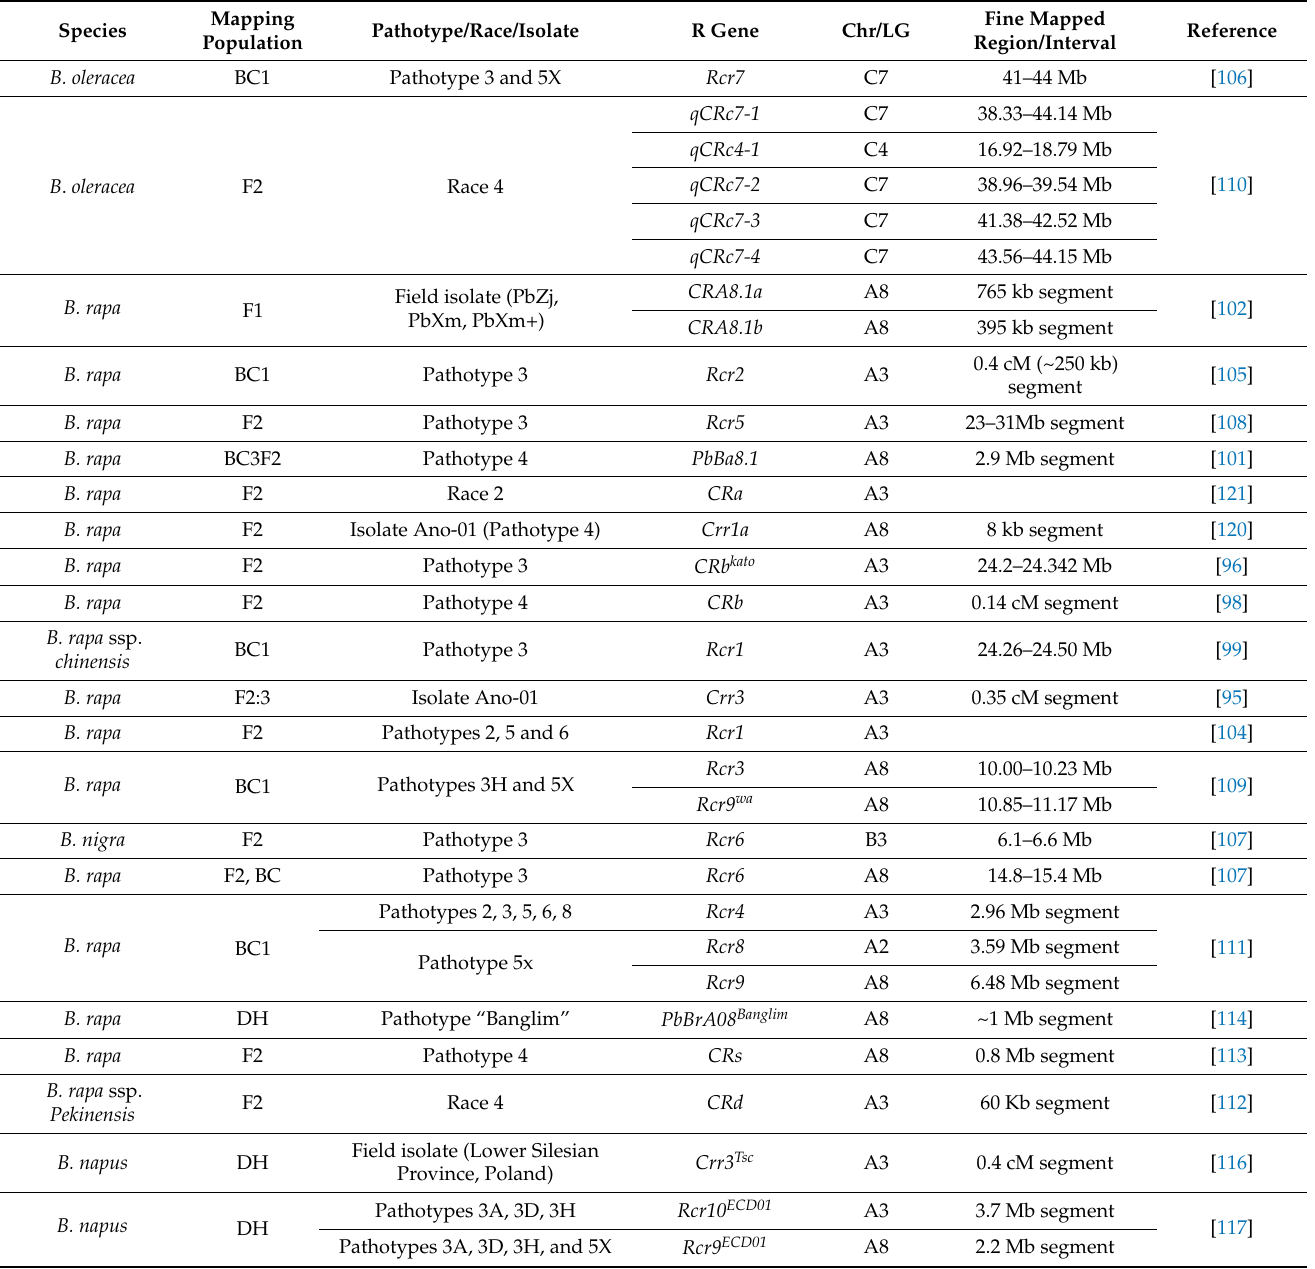
Table 2. List of clubroot resistance genes with NBS-LRR domain in Brassica